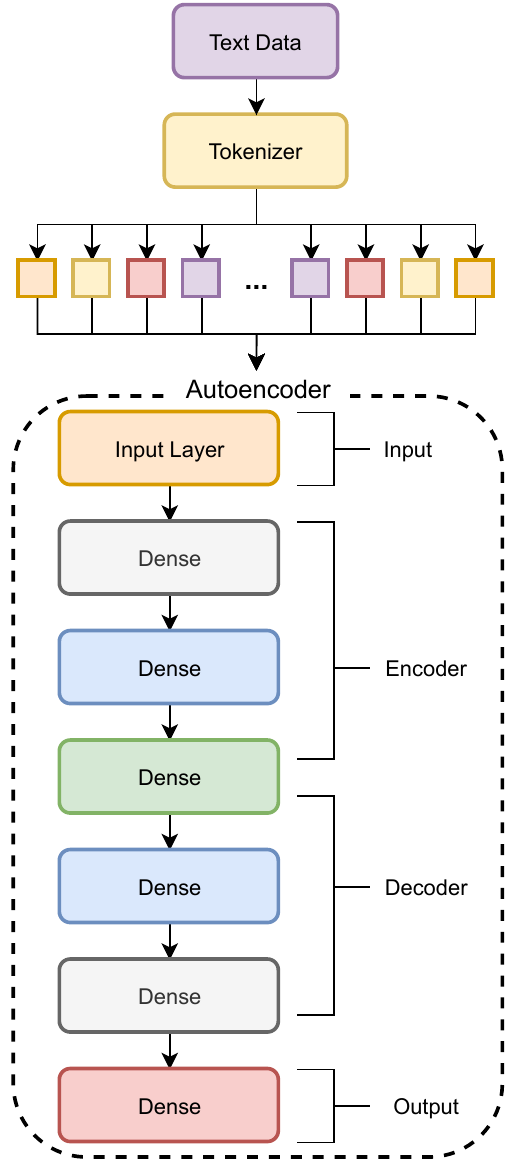
Figure 4. Autoencoder layers and input